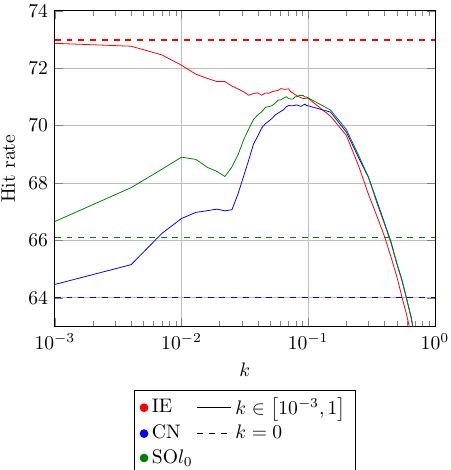
Figure 10. Hit rate from the centaur shapes over different damping parameters k . Solid lines indicate changing damping parameters and dashed lines denote a fixed damping parameter ( k = 0). The colours distinguish between the different numerical methods: red for IE, blue for CN and green for SO l 0